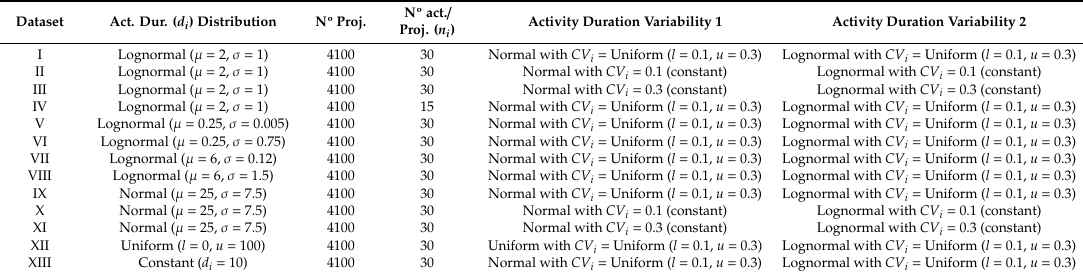
Table 2. Project dataset configurations of activity durations (one per set) and activity duration variabilities (two per set). Act.—activity;